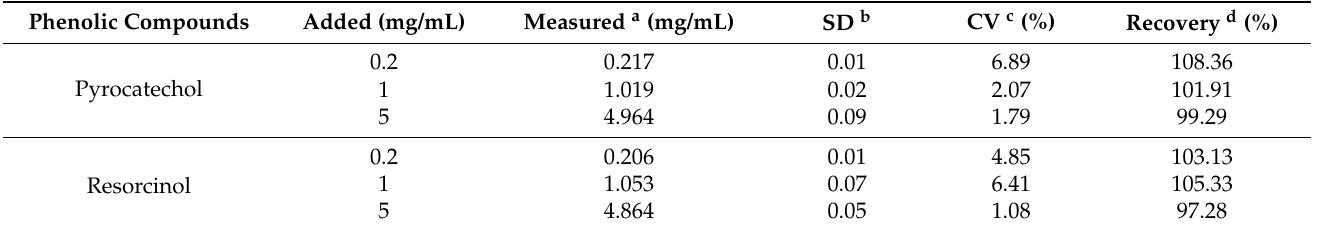
Table 1. Detection precision for the UV-light-driven MgAc-Fe 3 O 4 /TiO 2 -based system for the determination of phenolic compounds in spiked water samples. Phenolic